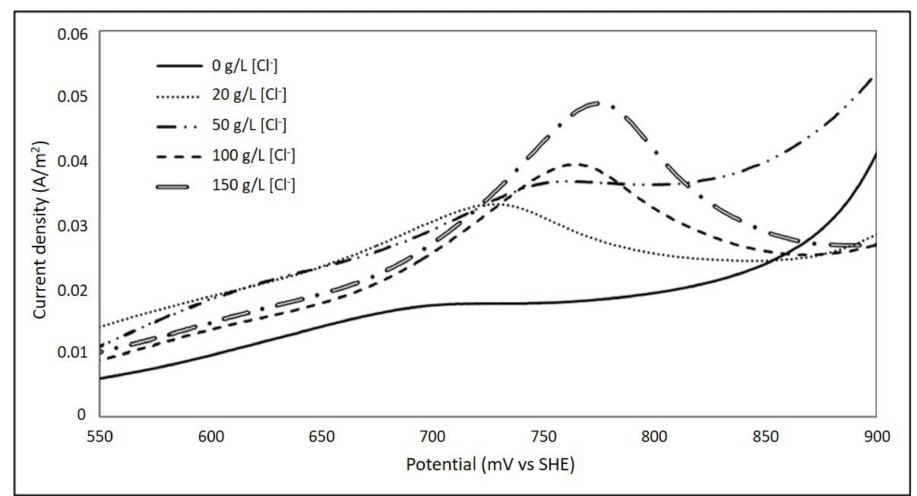
Figure 4. Effect of chloride ions on voltammograms (1 mV/s) at 0, 20, 50, 100, and 150 g/L [Cl − ] for the chalcopyrite electrode using a solution with 0.5 g/L [Cu 2+ ], 1.0 g/L [Fe 2+ ], and pH 1 adjusted with sulphuric acid at 25 ◦ C.